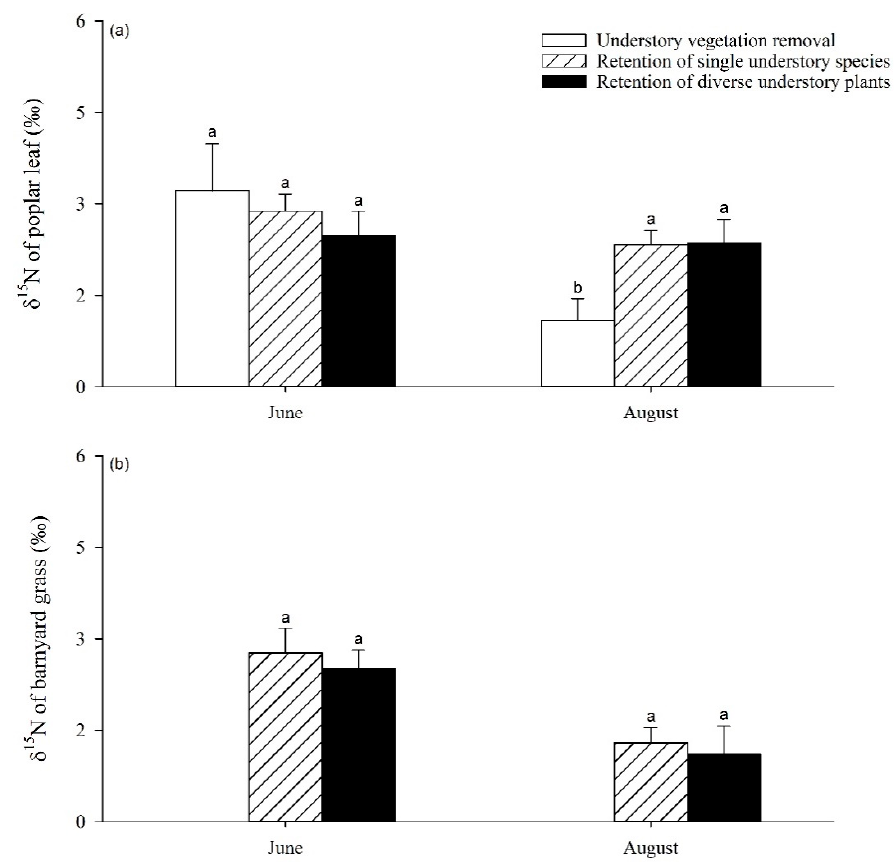
Figure 5. Variation in δ 15 N values of poplar leaf ( a ) and barnyard grass ( b ) with increases in understory vegetation species richness. Different letters indicate significant differences between treatments at p < 0.05. Table 1. Variation in inorganic N content and δ 15 N value with increase in understory vegetation species richness. UR, RS and RD refer to the treatments of understory vegetation removal, the retention of a single main understory plant species, and the retention of natural diverse understory vegetation, respectively. Lowercase letters indicate significant differences in inorganic N content and δ 15 N value between treatments ( p <